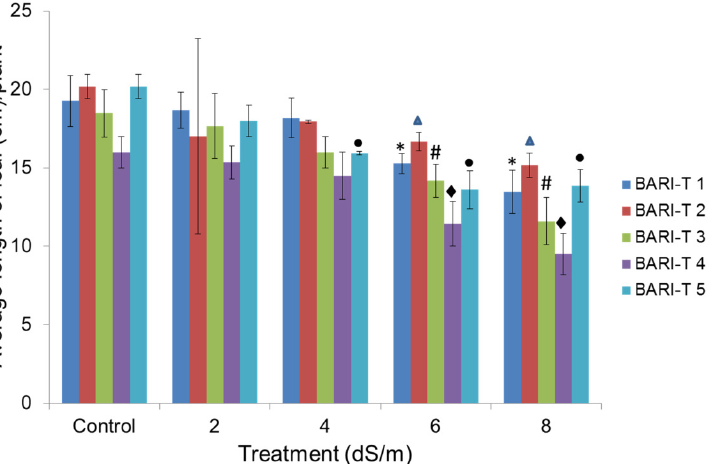
Fig. 1. Effects of NaCl-salinity on number of leaves in five BARI-T plants. Error bars indicate mean ± SD (n=3). Asterisk *, , #, ♦ , and • denote a significant difference between the saline-treated group and control group of BARI-T 1, BARI-T 2, BARI-T3, BARI-T 4 and BARI-T 5, respectively at p<0.05.